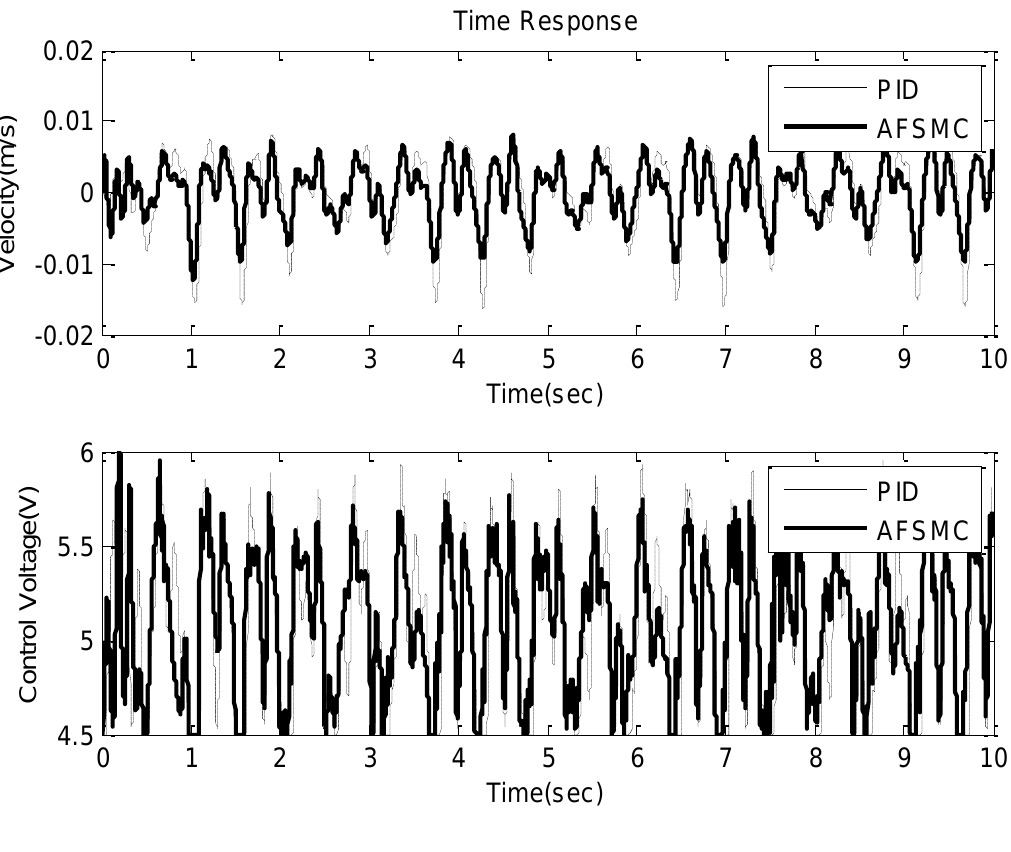
= 1, k = 0.01, k = 0.5) isolator under random p i d